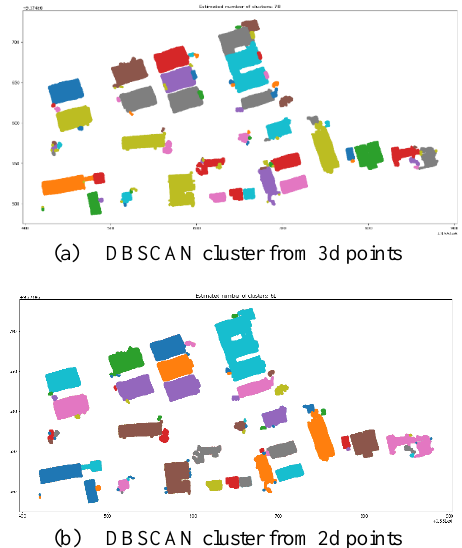
Figure 3. The DBSCAN result using eps =1.2m and minPts =3 From one building segment, ideally corresponding to a roof, a concave-hull algorithm is used to find the outermost points of that segment. This study uses a generalization of the convex hull, named alpha-concave hull modified by Asaeedi et al. (2003). It uses alpha to define the smoothness threshold. In order to preserve the building shape, the alpha threshold parameter of the concave hull may need to be adapted especially for noisy data.